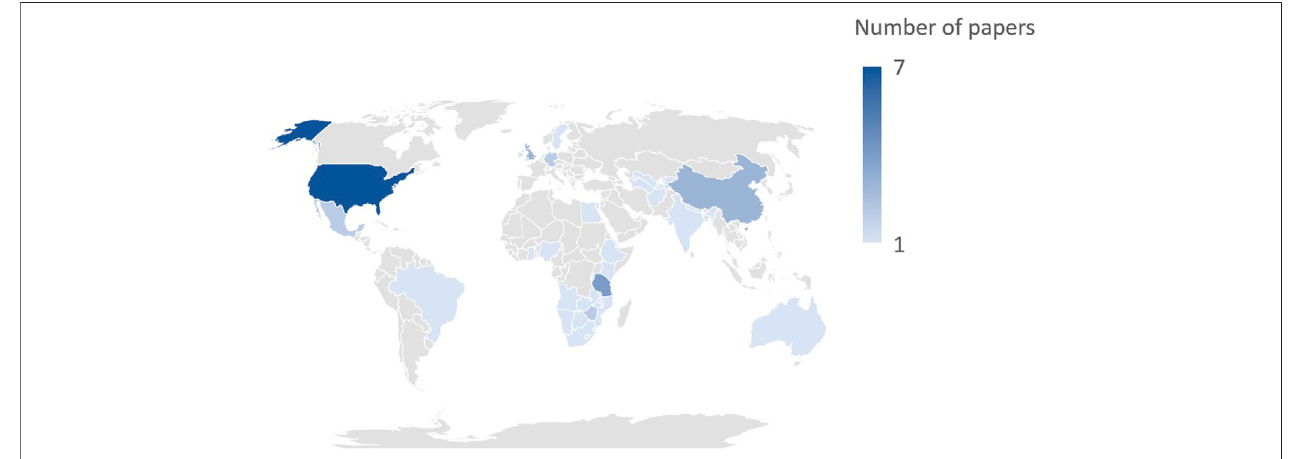
FIGURE 2 | Distribution of local and national case studies over